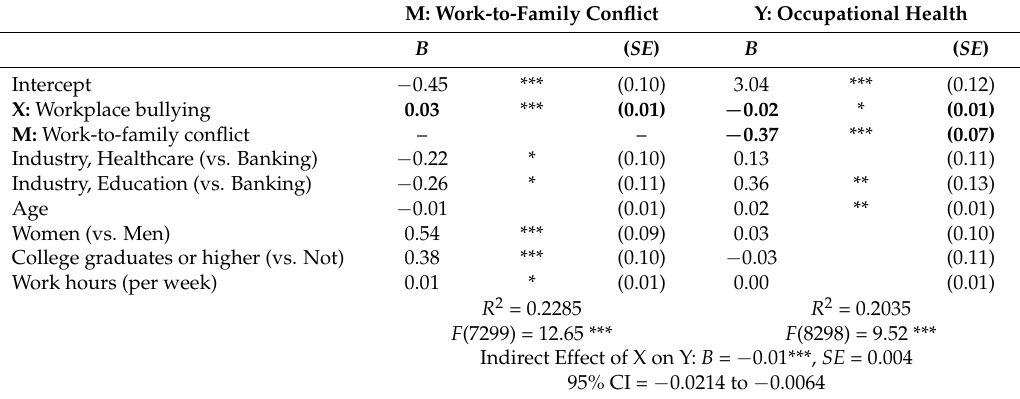
Table 3. The effect of workplace bullying on occupational health, mediated by work-to-family. M: Work-to-Family Conflict Y: Occupational Health